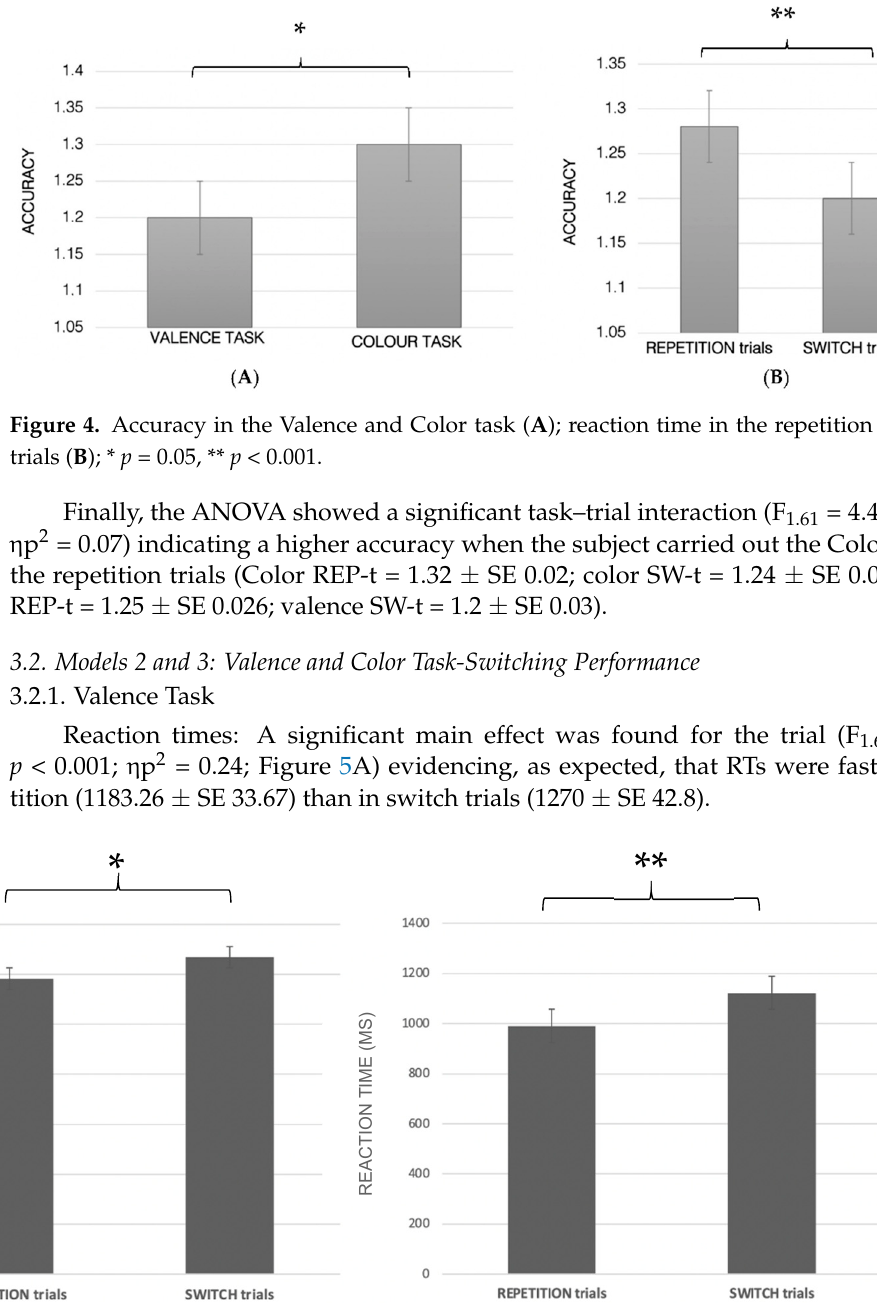
switch trials ( B ); * p < 0.001, ** p < 0.001.